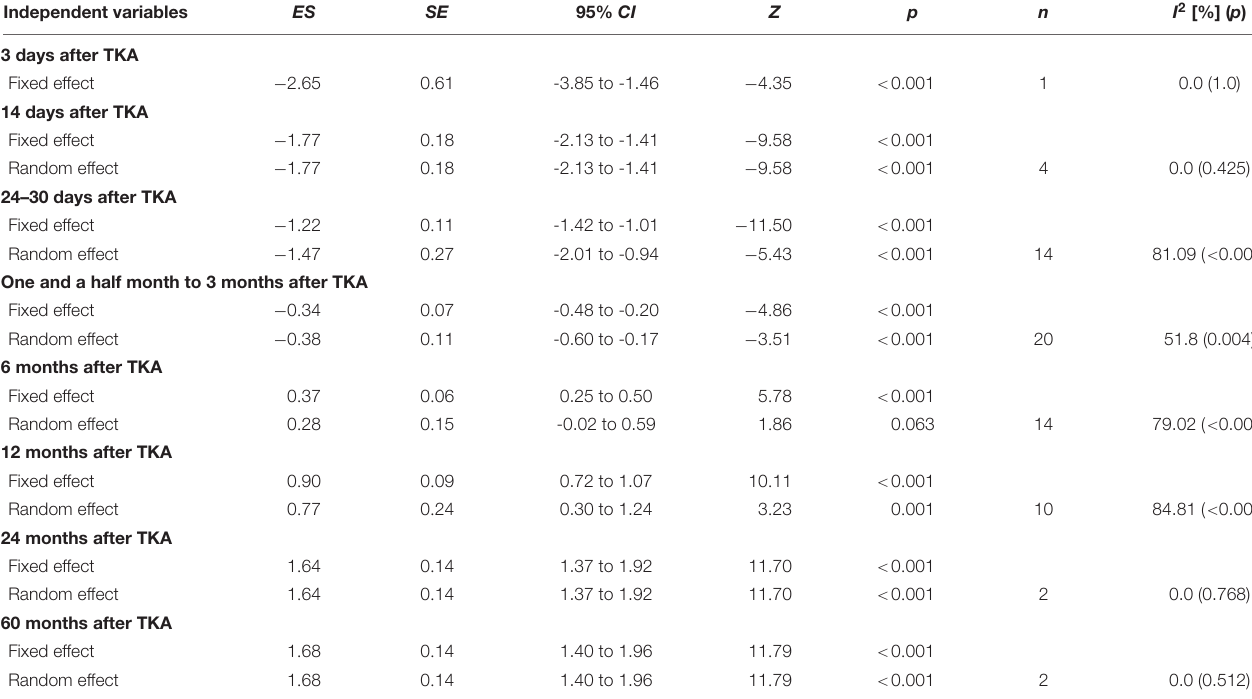
TABLE 3 | Effects of total knee arthroplasty on maximal isometric strength normalized to kilograms of body mass or BMI, considering different time periods of post-surgery evaluation. Independent